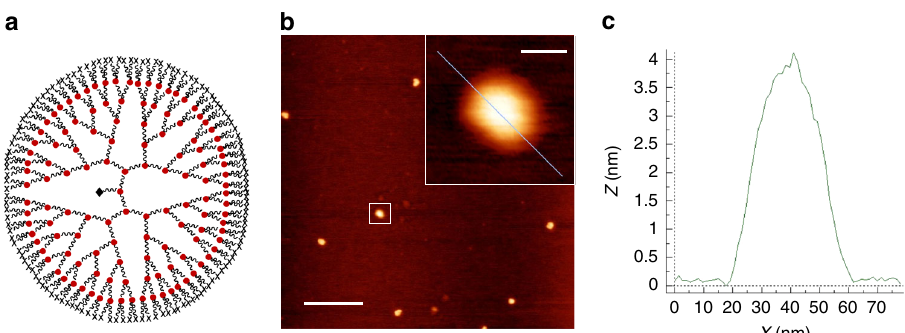
Fig. 3 Structure and microscopy images of the seventh generation dendritic hyperbranched polymer. a Schematic structures of the ideal polymer product, b height image (for the magni fi ed image, see inset). Scale bar: 200 and 20 nm (for the magni fi ed image), and c cross-sectional pro fi le obtained by AFM for a sample prepared by spin-casting onto a freshly cleaved mica surface with a solution of 10d (0.001 mg/ml in CHCl 3 ) prepared at a [ 6 ]/[ 9 ] ratio of 127, which corresponds to a dendritic generation N of 7 (Table 1,